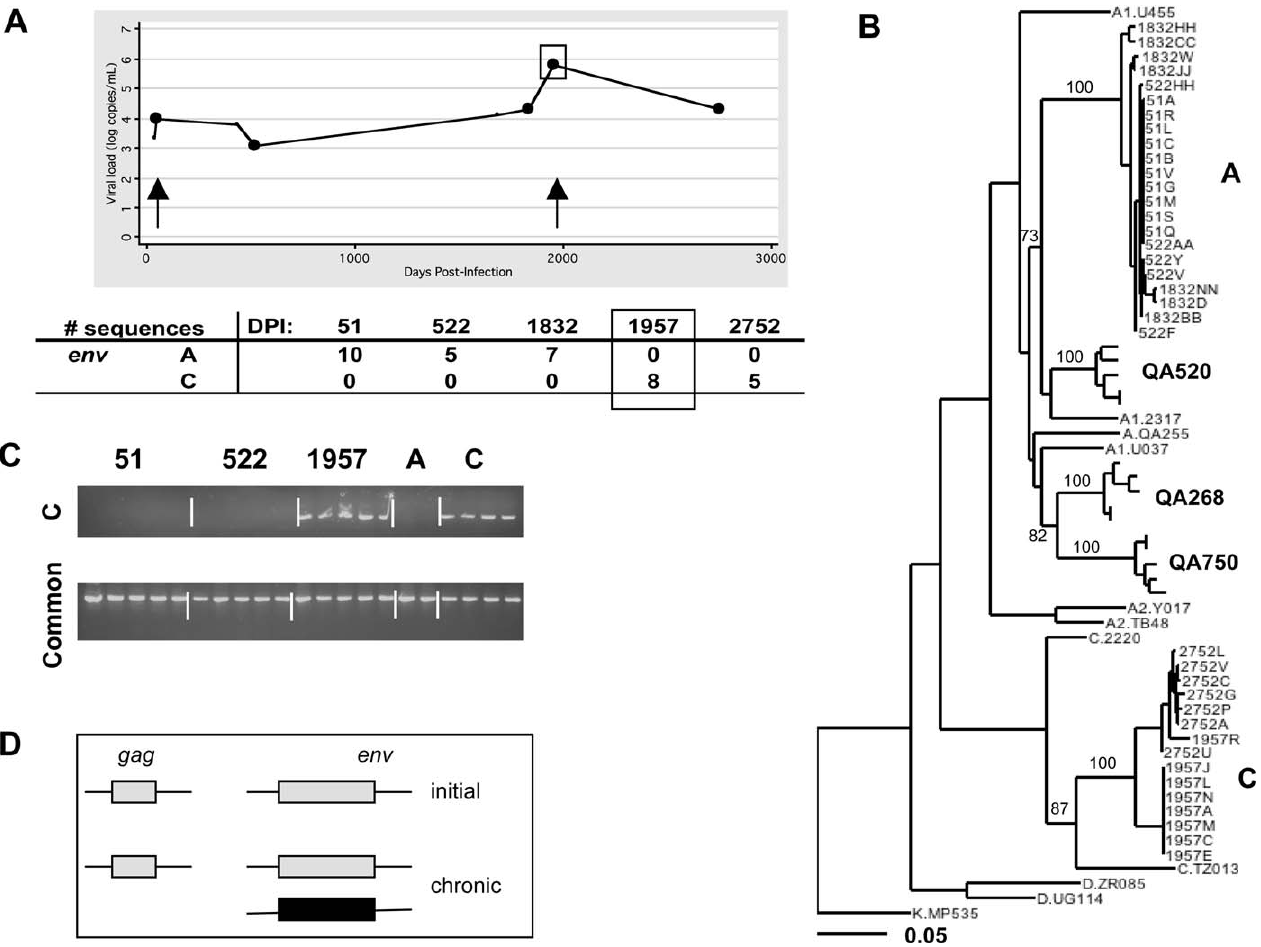
Figure 6. Case 4 (QD022): Intersubtype Superinfection (Subtype A–C) between 1,832 and 1,957 DPI Detected in env B) Maximum-likelihood tree of env sequences from all time points. Cluster A contains sequences from 51, 522, and 1,832 DPI, while cluster C contains sequences from 1,957 and 2,752 DPI. (C) Amplification of 50 env HIV-1 genome copies from the indicated time points using strain-specific primers (top panel) and common primers (bottom panel). (D) Summary of the strains detected. Light gray ¼ subtype A; black ¼ subtype C.